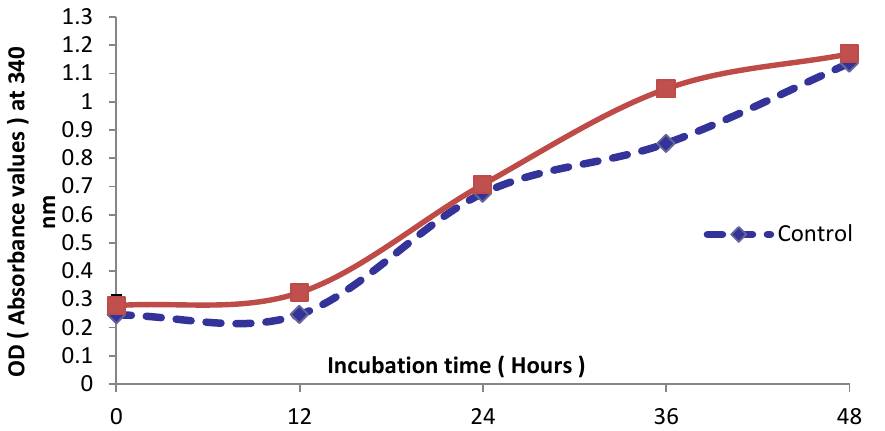
Figure, 3: Influence of mild pulsed electric field conditions on the bile tolerance of Lactobacillus acidophilus